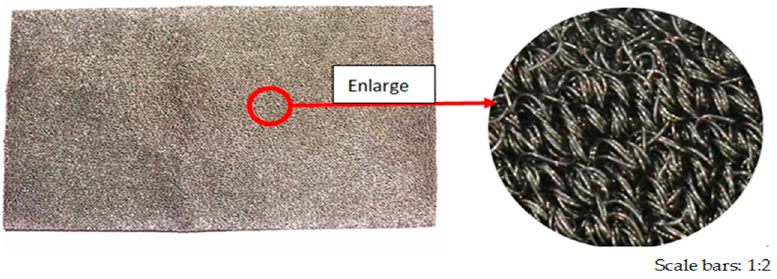
Figure 2. Large-size metal rubber sheets.